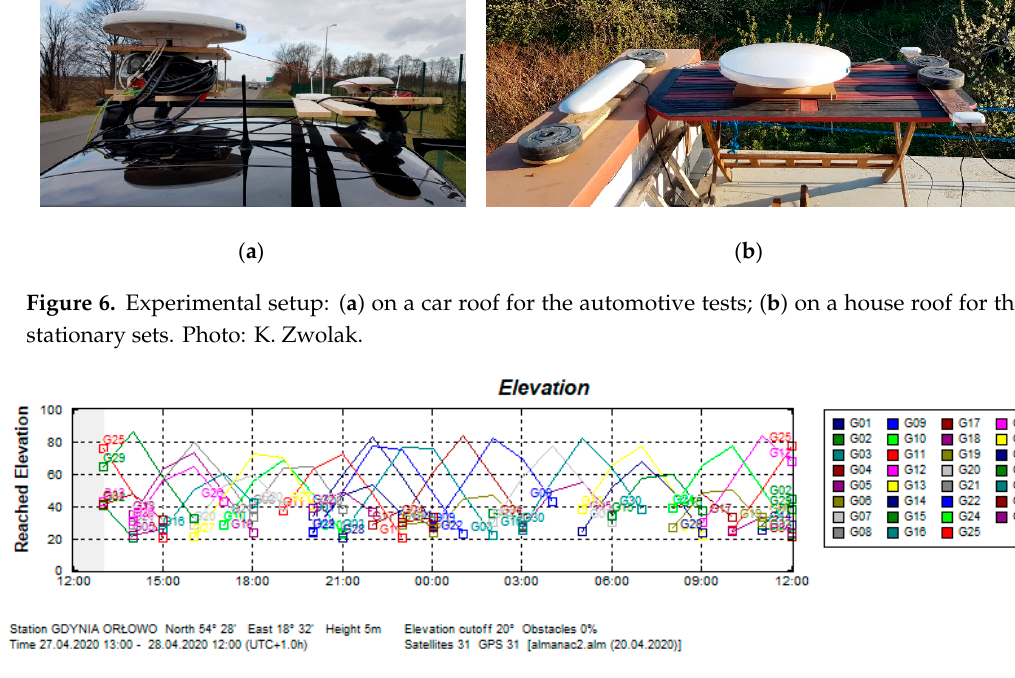
Figure 7. GPS satellite elevations during the experiment on 27–28 April 2020. (Source: Trimble Planning 2.9, 2010.).